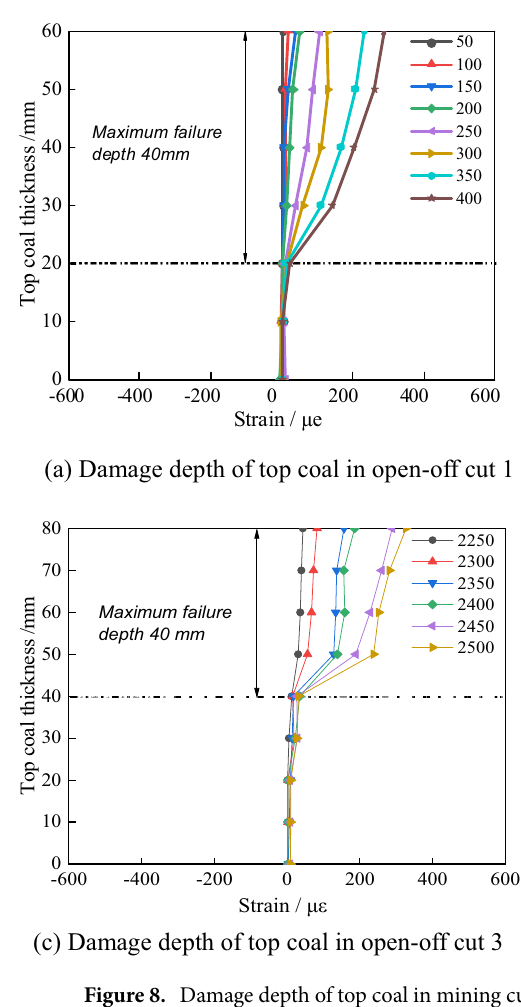
Figure 8. Damage depth of top coal in mining cut of upper layered working face.